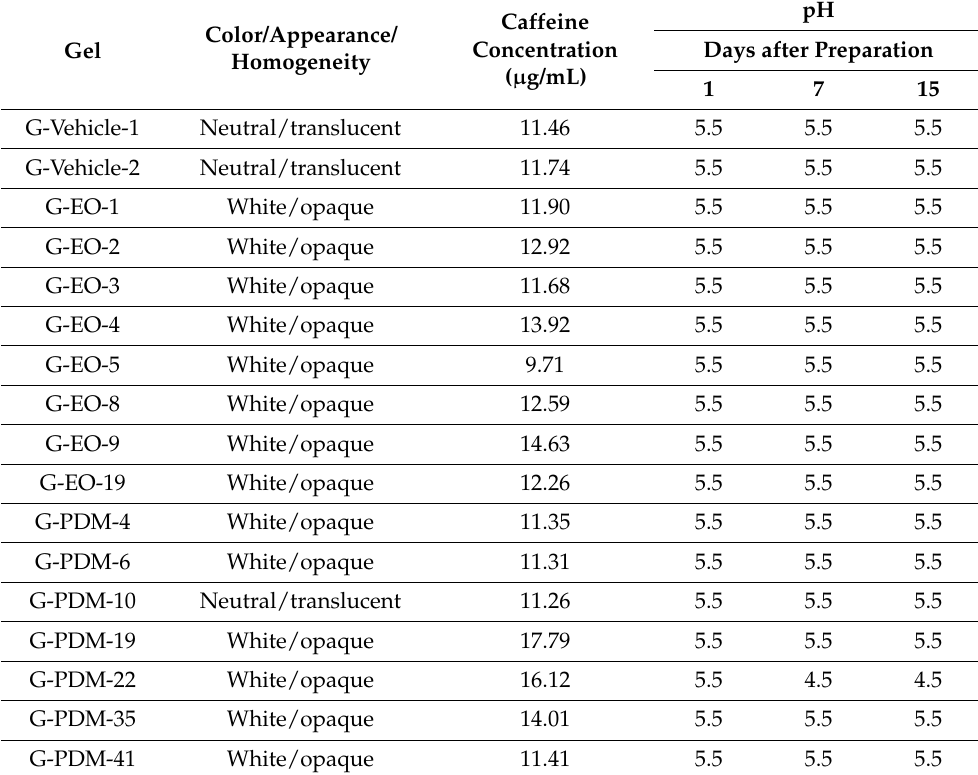
Table 2. Caffeine gels contain essential oils (EOs) and plant-derived metabolites